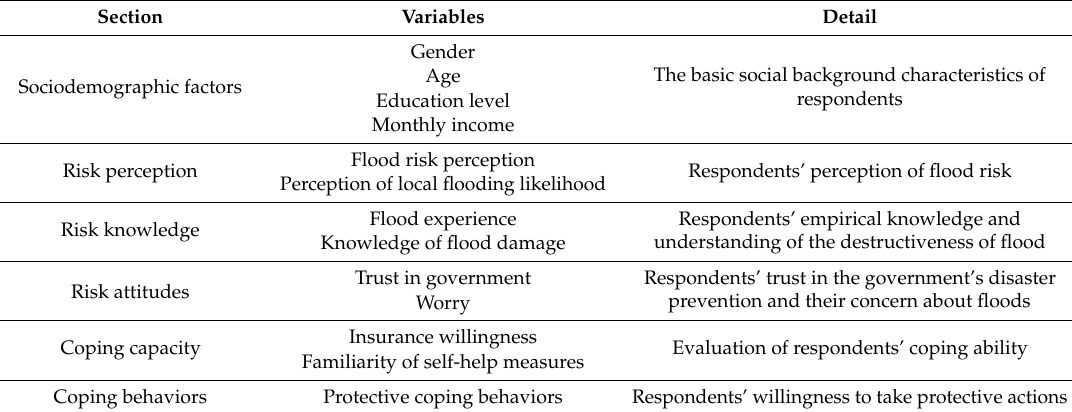
Table 1. Definition of measurement and influential factors of protective coping